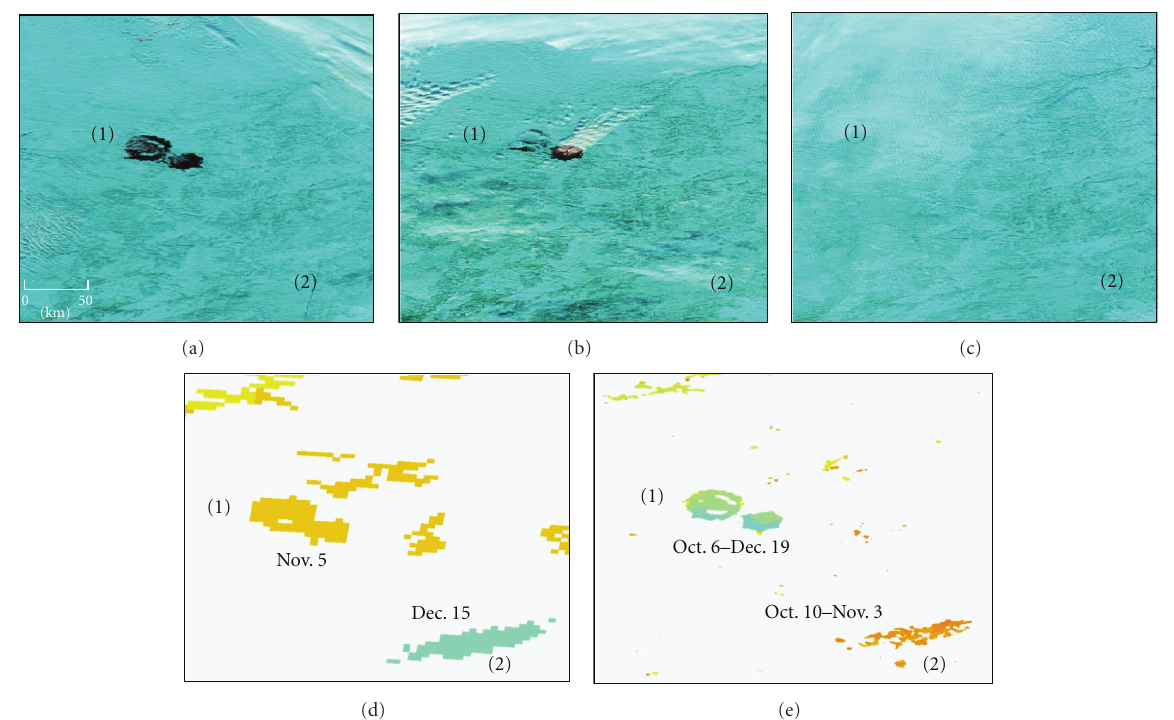
Figure 5: Freeze-up for L. `a L’eau Claire (1) and L. Beinville (2) 2009 detected from (a, b, and c) MODIS bands 7,2,1 on specified dates, (d) IMS-detected ice-on dates, and (e) MODIS snow product-detected ice-on dates. Locations highlighted in Figure 1. Table 4: Correlation R values for pixels containing both IMS and MODIS lakes (456grid cells). All values are significant at the 0.001 level.